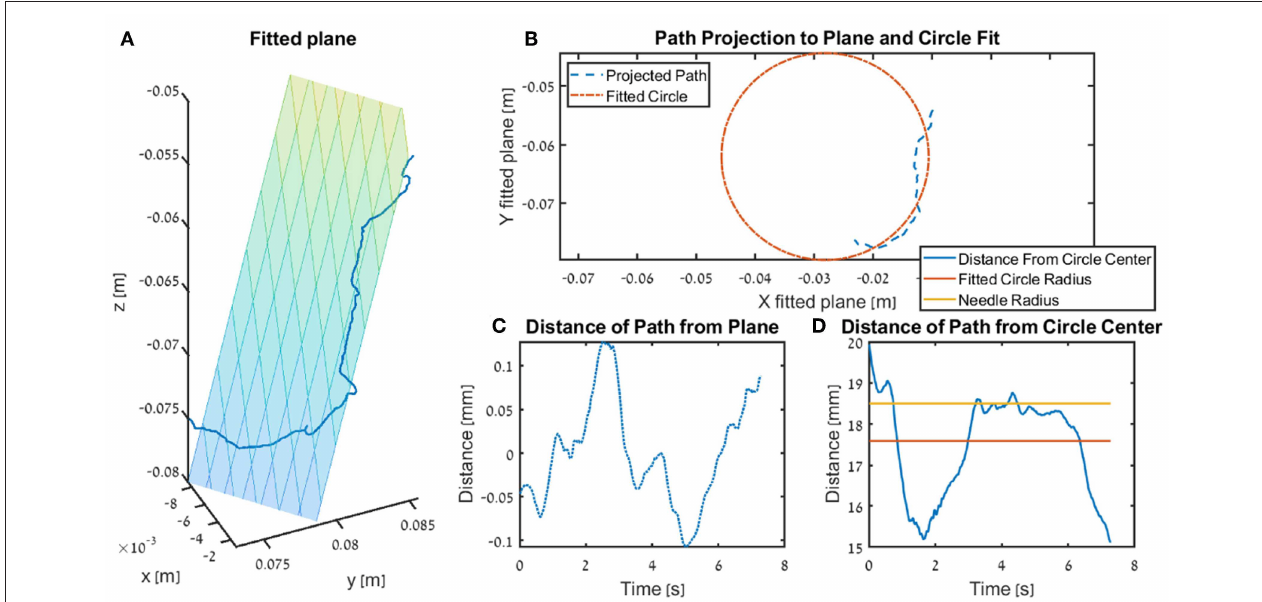
FIGURE 6 | Illustration of the fitted plane and circle use in the kinematics metrics circle deviation and plane deviation for a single trial. In the figure we present the insertion subtask for one participants that received DF feedback, and the trial is recorded from the teleoperation setup. (A) The fitted plane and the path. (B) An example of a projected path (seen in 3 dimension in A ) and the circle fitted to that path. (C) The distance of the path to the plane (i.e., shortest distance of each point). (D) The radius of the surgical needle (yellow) used in the experiment, together with the radius of the fitted circle (red) and the distance of the tooltip path from the center of the fitted